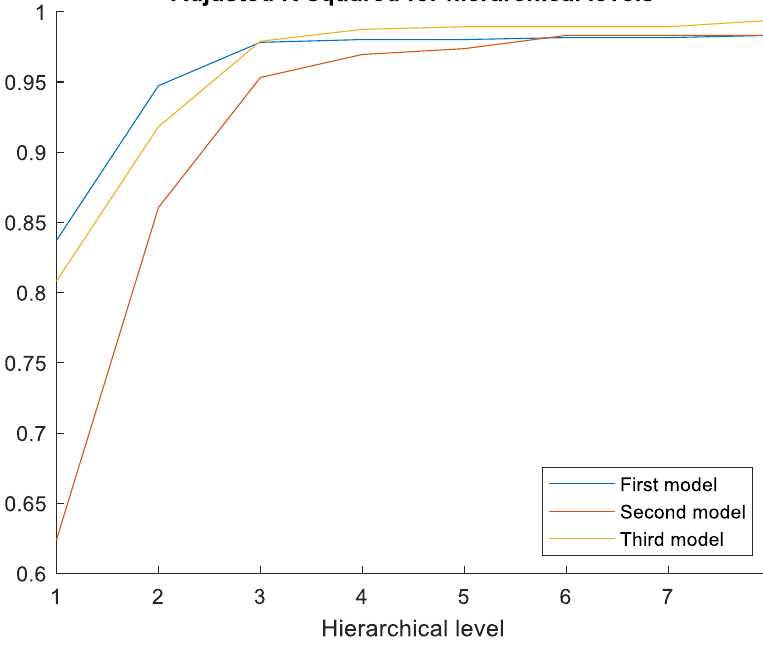
Figure 8. Adjusted 𝑅 2 for each hierarchical